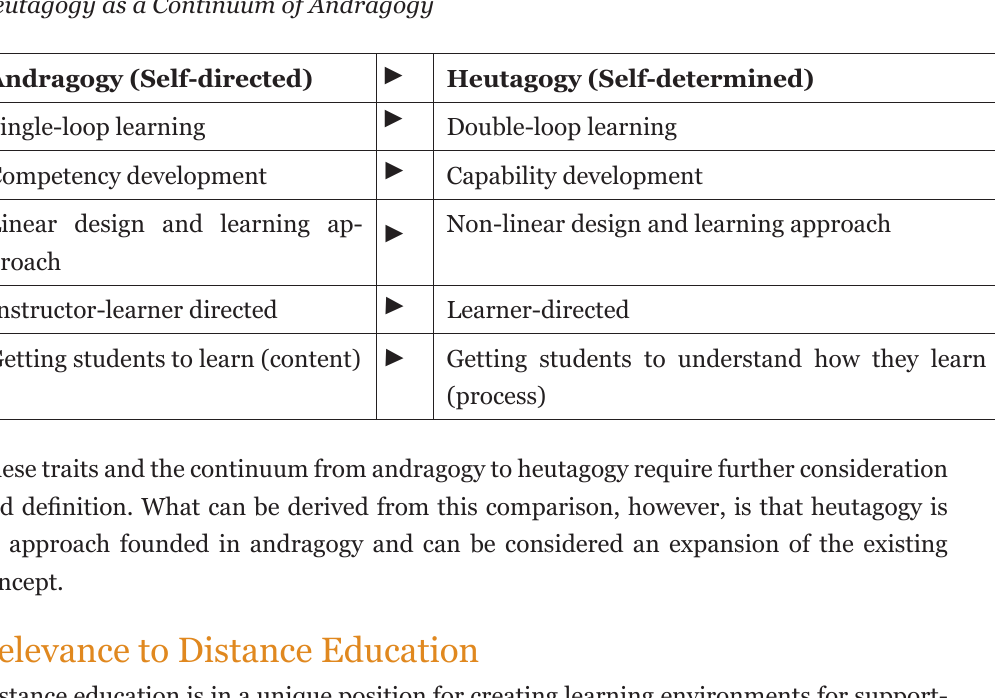
Table 1 Heutagogy as a Continuum of Andragogy Andragogy (Self-directed) Heutagogy (Self-determined) Single-loop learning Double-loop learning Competency development Linear design and learning ap- proach Instructor-learner directed Getting students to learn (content) Getting students to understand how they learn